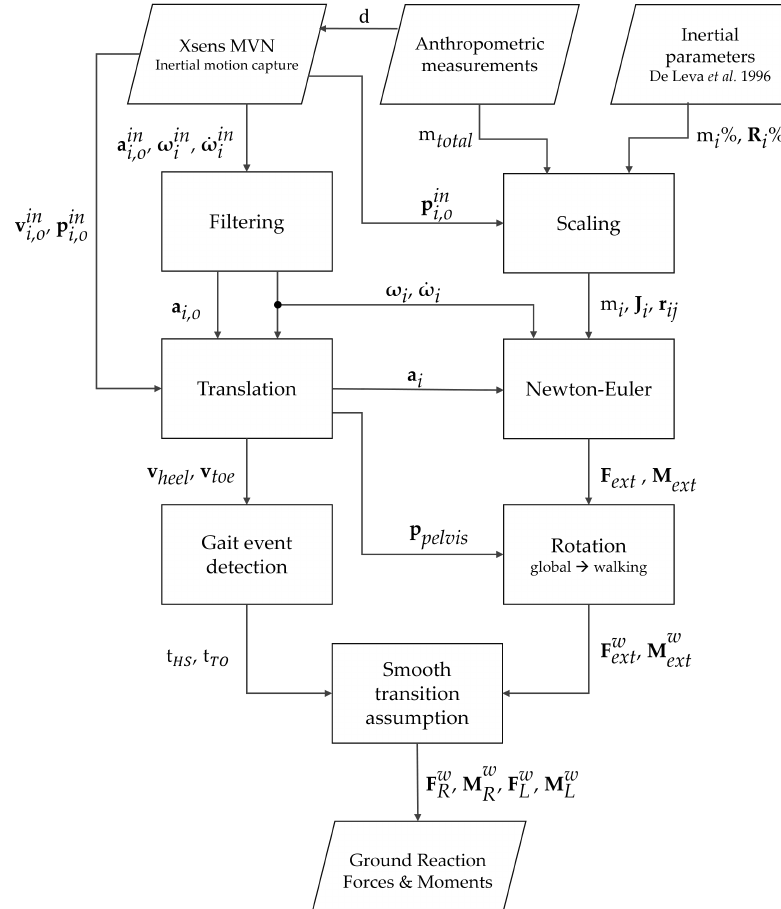
Figure 5. Block diagram of the algorithm used to estimate the GRF&M from anthropometry and inertial motion capture. p = position, v = velocity, a = acceleration, ω = angular velocity, ˙ ω = angular acceleration, F = force, M = moment, t = time, d = anthropometric dimensions, m = mass, R = radius of gyration, J = inertia tensor. Superscript “ in ” indicates quantities derived directly from the IMC system, and w denotes quantities expressed in the coordinate system defined by the walking